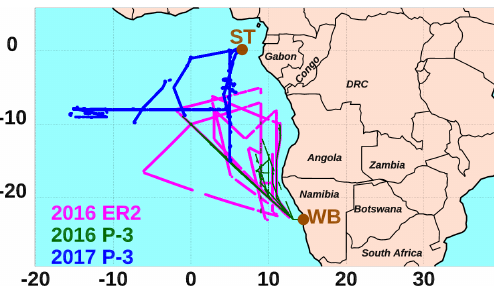
Figure 2. Locations of AOD measurements from the HSRL-2 aboard the ER-2 during ORACLES 2016 (in magenta), the 4STAR aboard the P-3 during ORACLES 2016 (in green), and both instru- ments aboard the P-3 during ORACLES 2017 (in blue). Walvis Bay and São Tomé are denoted by WB and ST,